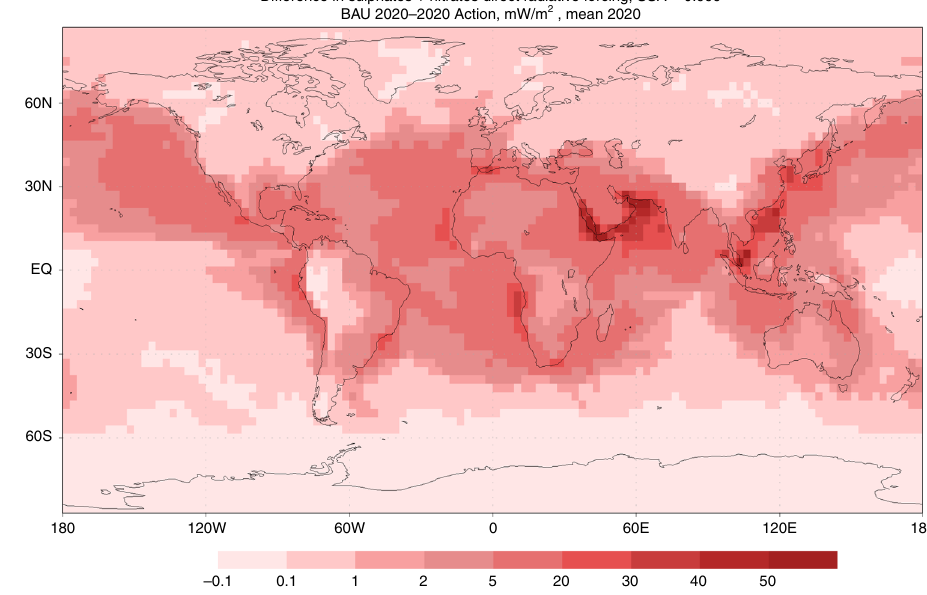
Fig. 5 Direct radiative forcing due to low-sulphur fuel standards. Direct radiative forcing in mWm − 2 at the top of the atmosphere from scattering sulphate and nitrate aerosols due to implementation of the International Maritime Organization ’ s low-sulphur fuel standards for ships. Global mean is 3.9 mW m −